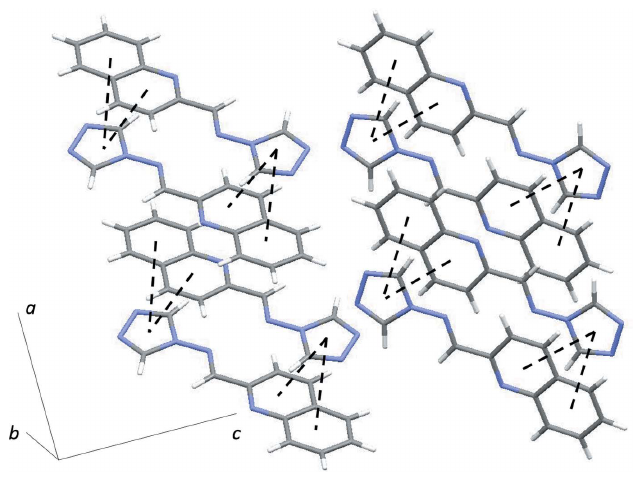
Figure 3 A partial packing diagram of the title compound, showing a molecular column formed by (cid:2) – (cid:2) stacking interactions.